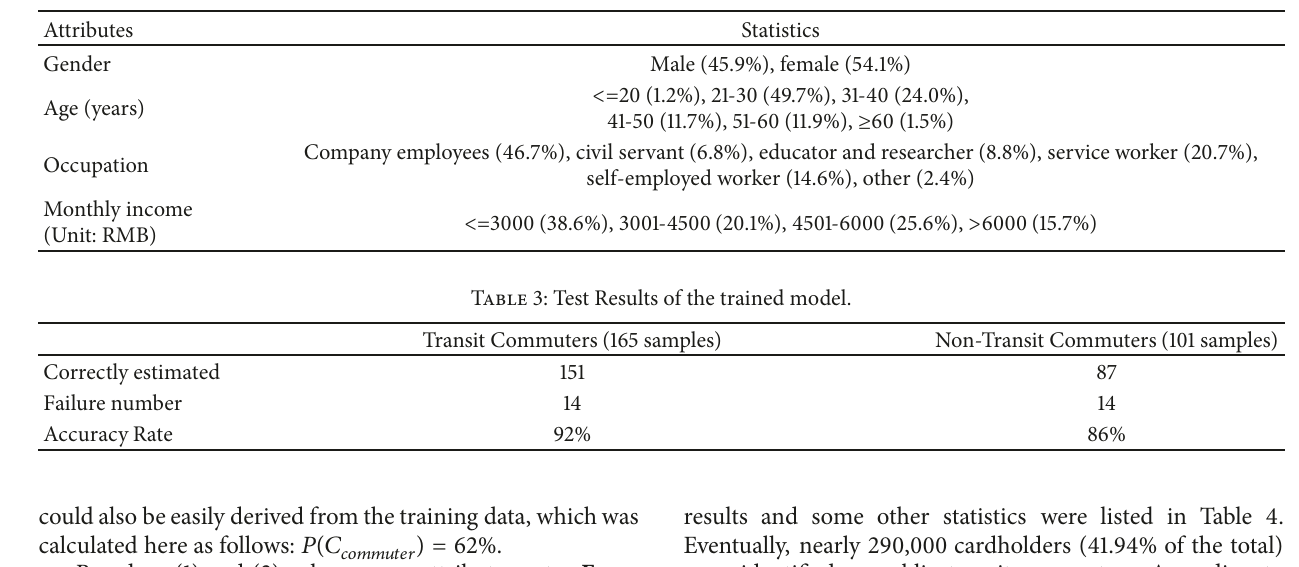
Table 2: Descriptive statistics of valid samples.